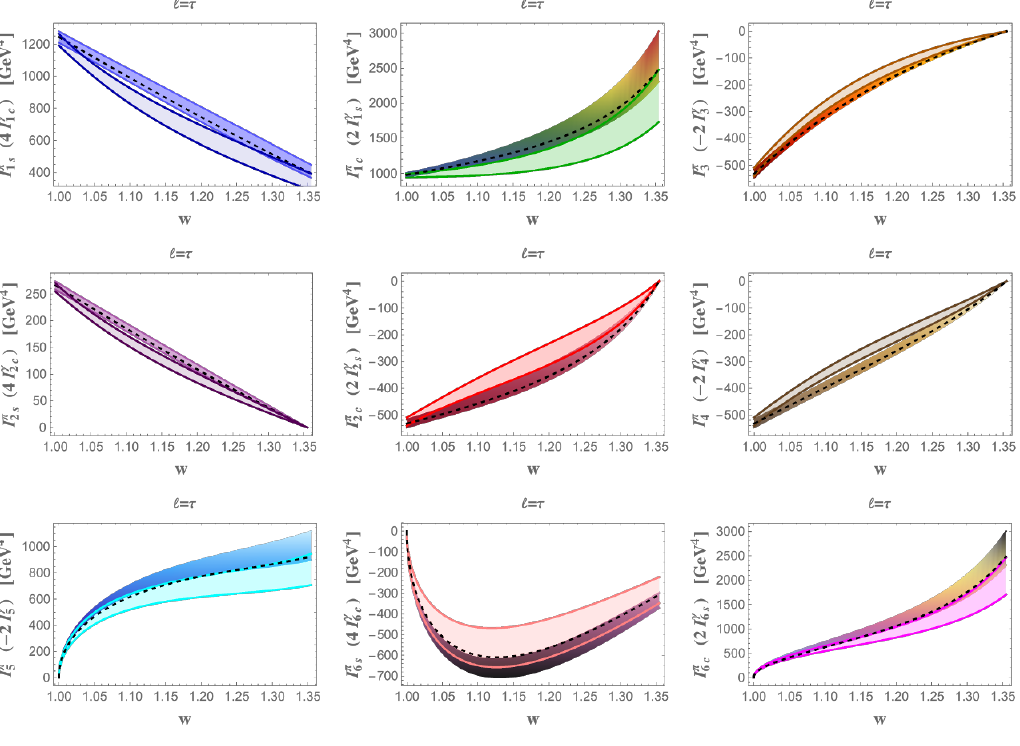
Figure 3 . Angular coe(cid:14)cients in the fully di(cid:11)erential decay distribution eq. (3.1) for ‘ = (cid:28) in SM. The coe(cid:14)cients in (3.2) are obtained using (3.5). Color code as in (cid:12)gure